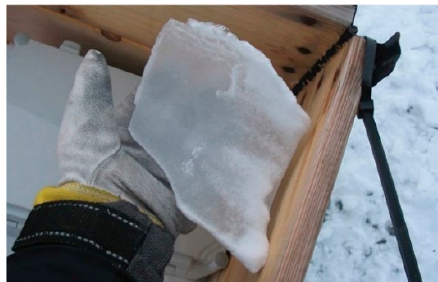
Figure 3. Ice piece thrown from a WT in Arctic Norway WF [36]. Reprint with permission from author [Matthew Homola], 2022, NTNU Norwegian University of Science and Technology.